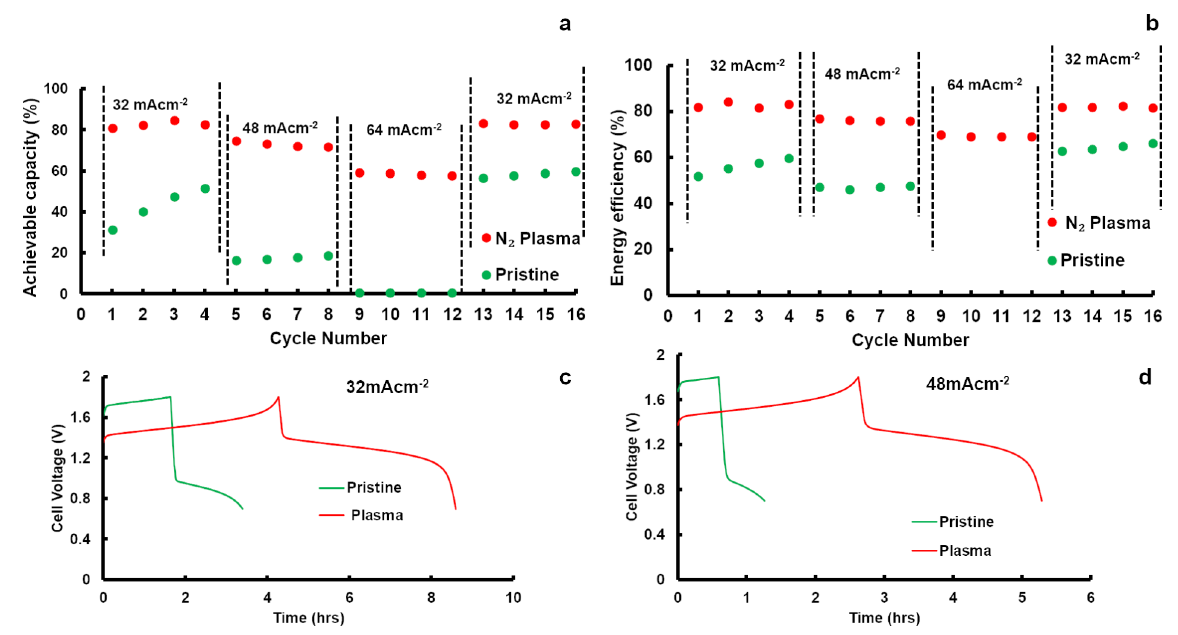
Figure 6: Single-cell measurement results with pristine (green) and N 2 -plasma-treated samples (red). a) Maximum discharge capacity obtained during cycling, b) energy efficiency achieved during cycling, c) charge–discharge curve obtained for cycling at 32 mA cm − 2 , d) charge–discharge curve ob- tained for cycling at 48 mA cm − 2